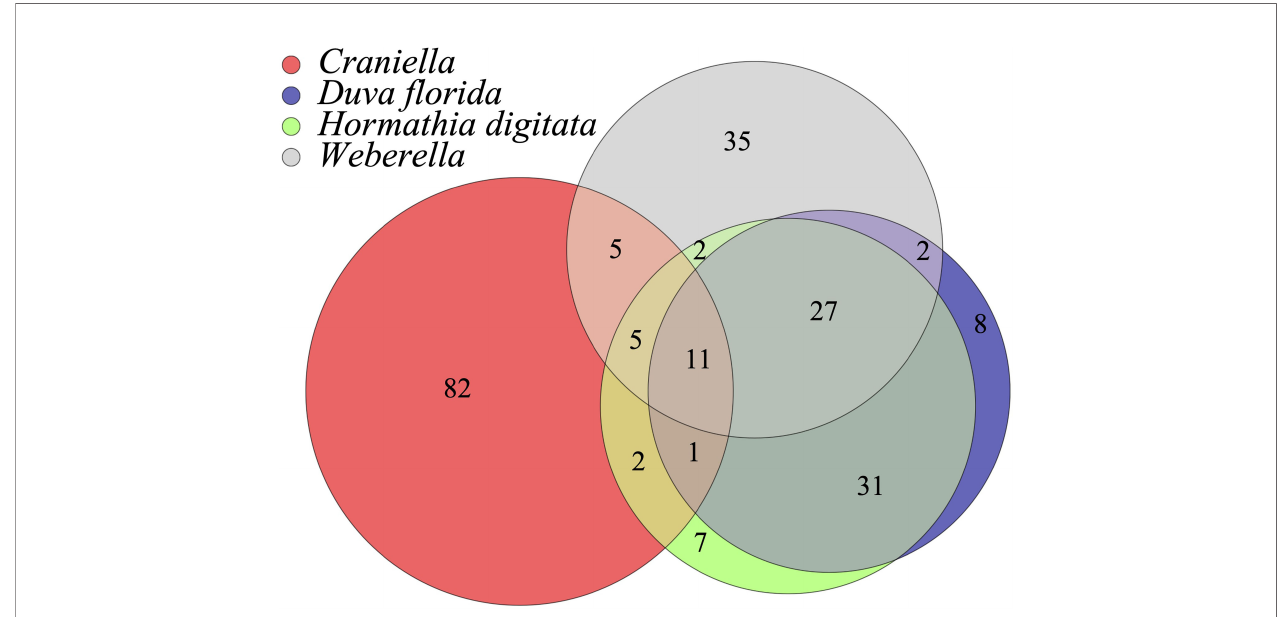
FIGURE 9 | Venn diagram of the shared fatty acids (FAs) between epibenthic